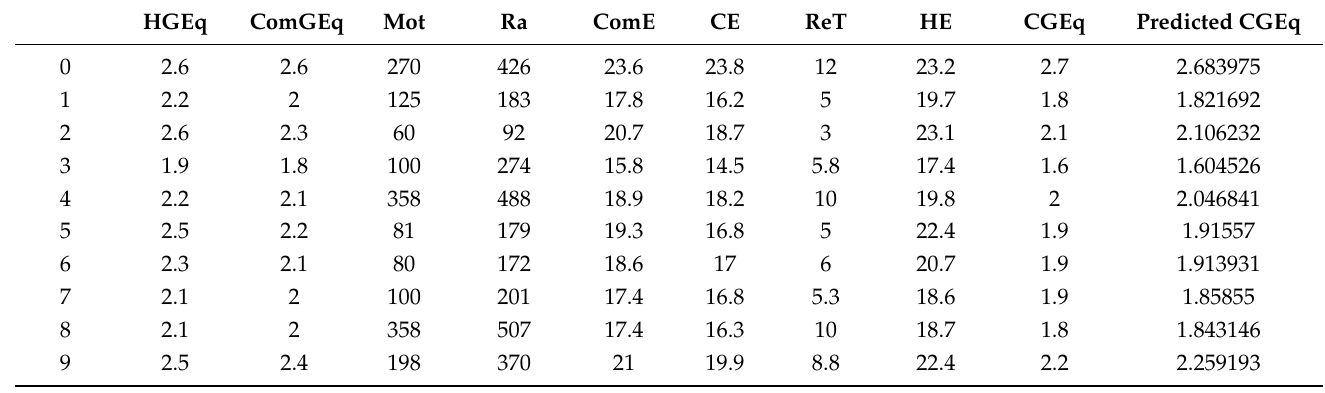
Table 6. Predicted and desired city gasoline litre consumption equivalent.